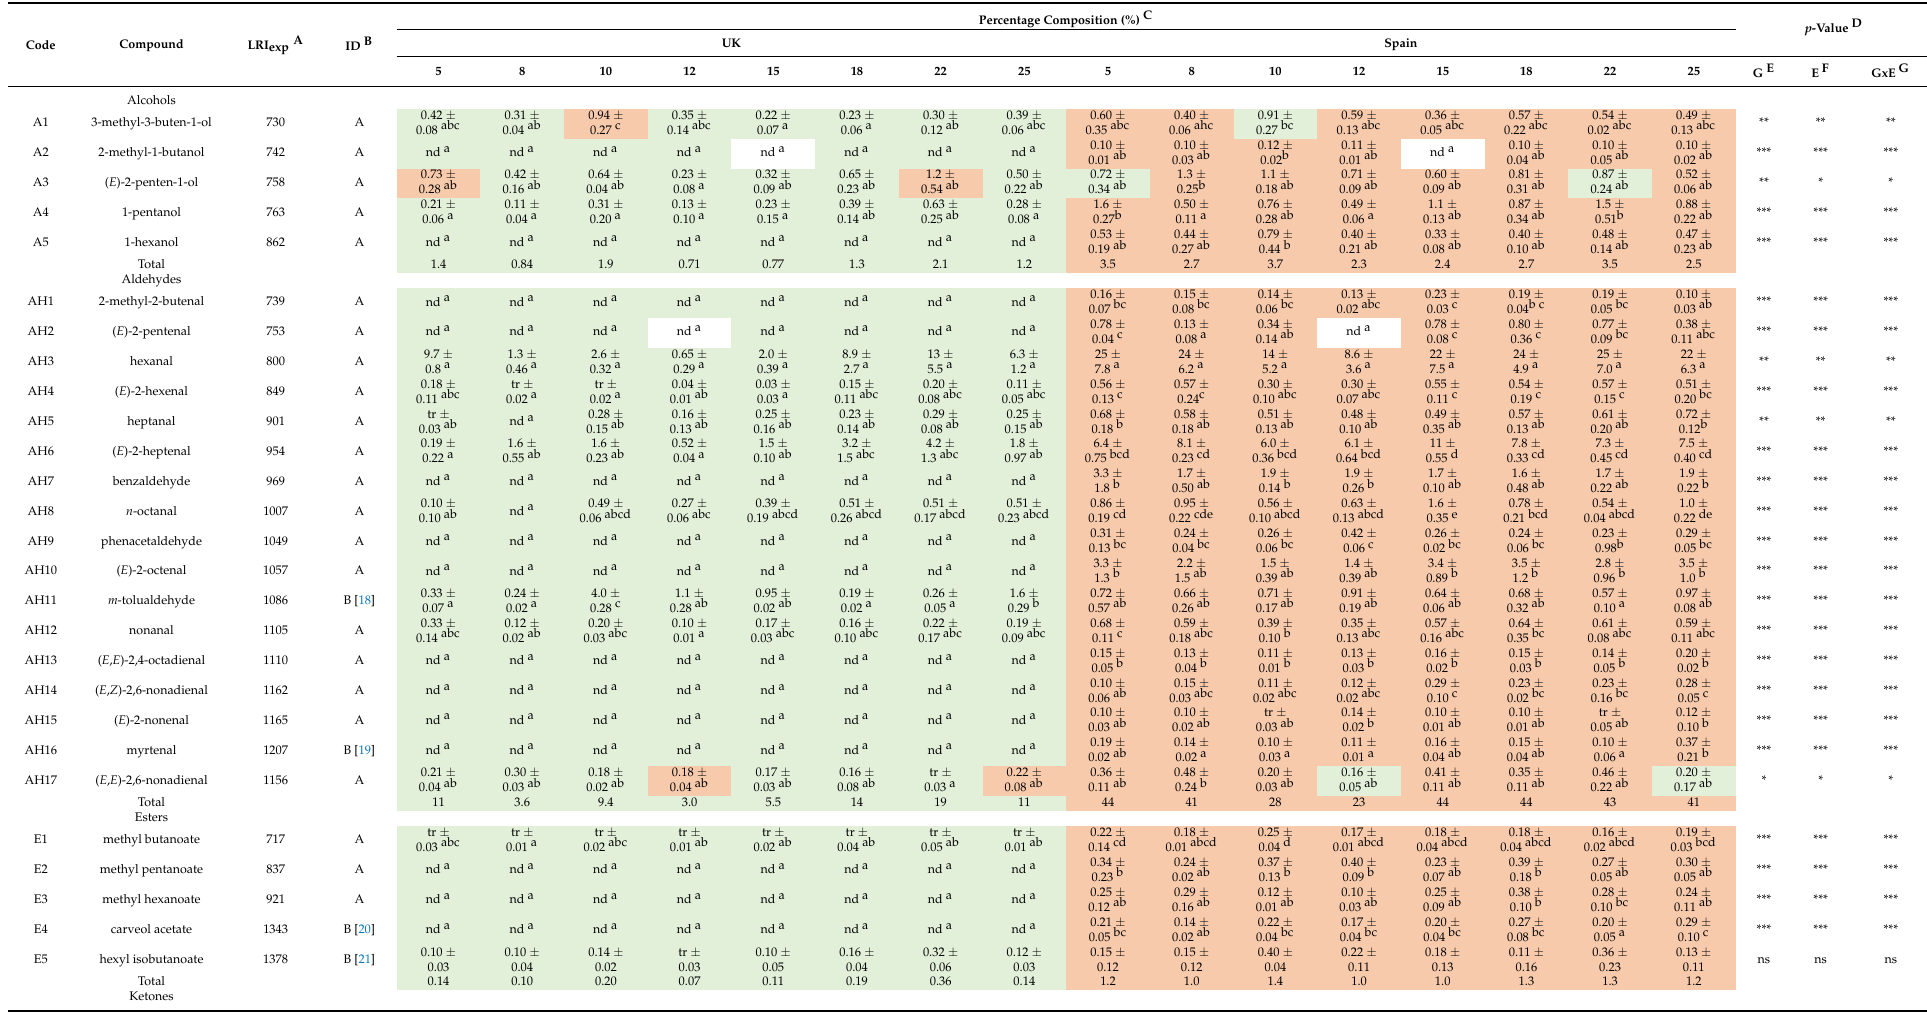
Table 1. Percentage composition of volatile compounds identified in the headspace of eight celery genotypes using SPME GC/MS and harvested in UK 2018 and Spain 2019.